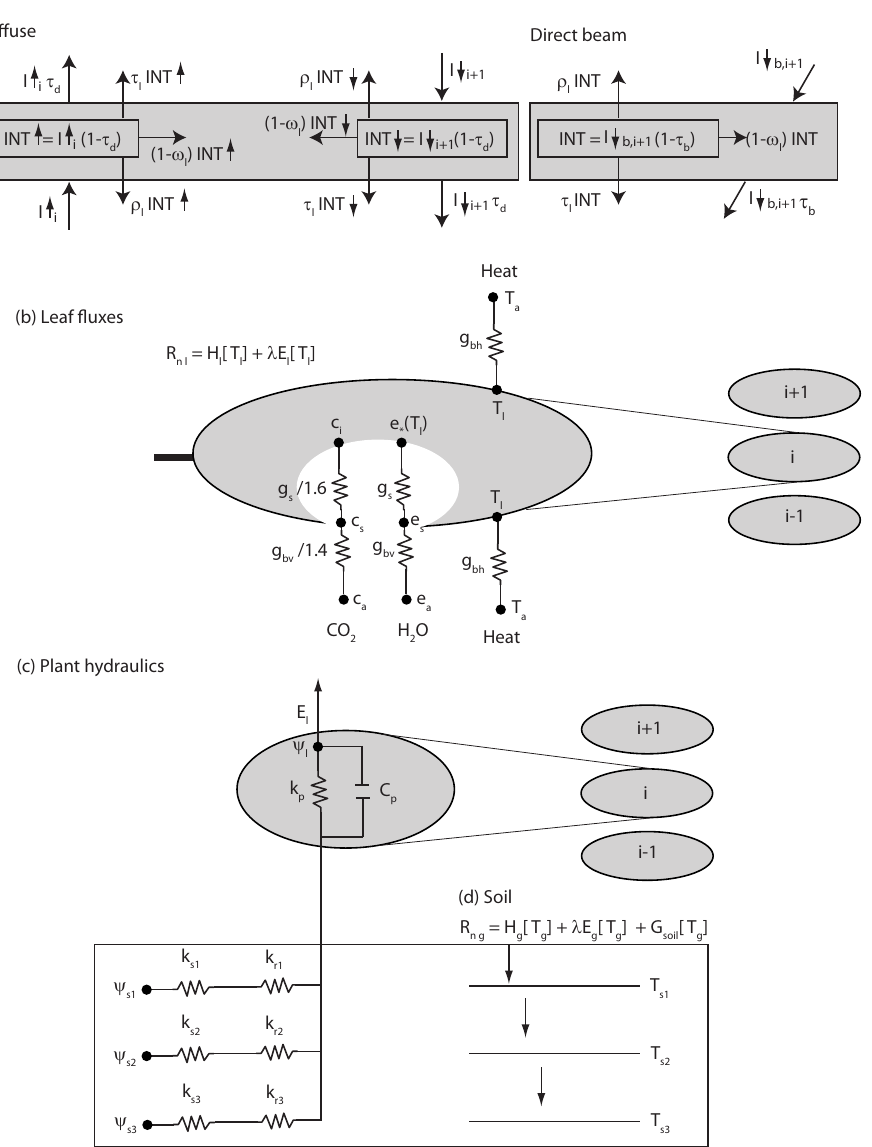
Figure 1. Overview of the main processes in the canopy model. The canopy is represented by n leaf layers with layer i + 1 above layer i . (a) Diffuse and direct solar radiation for layer i + 1. Diffuse radiation passes through the layer, proportional to τ d . The intercepted fraction (1 − τ d ) is scattered forward ( τ l ), scattered backward ( ρ l ), or absorbed (1 − ω l ; ω l = τ l + ρ l ). The intercepted direct beam (1 − τ b ) is similarly absorbed or scattered. Longwave radiation is similar to diffuse radiation, with ω l = 1 − ε l and the intercepted longwave radiation is reflected ( ρ l = ω l , τ l = 0). (b) Leaf sensible heat, transpiration, and CO 2 fluxes. Leaf temperature ( T l ) is the temperature that balances the energy budget. Sensible heat is exchanged from both sides of the leaf, proportional to the leaf boundary layer conductance ( g bh ) and the temperature gradient with air ( T l − T a ). Water vapor is lost from the stomatal cavity to air, proportional to the vapor pressure deficit ( e ∗ (T l ) − e a ) and stomatal ( g s ) and boundary layer ( g bv ) conductances in series. CO 2 similarly diffuses from the canopy air into the stomata, proportional to the gradient c a − c i . (c) Soil water uptake by a canopy layer. Each canopy layer has an aboveground plant stem conductance ( k p ) and a capacitance ( C p ). Multiple root layers occur in parallel with a conductance comprised of soil ( k s ) and root ( k r ) components in series. The soil conductance varies with soil water potential ( ψ s ). (d) Soil energy balance and heat flow. Sensible heat, latent heat, and soil heat fluxes depend on ground temperature ( T g ). The soil heat flux is transferred within the soil profile using a Crank–Nicolson formulation with soil heat flux as the upper boundary condition and soil heat capacity and thermal conductivity specified from soil texture, mineralogical properties, and soil water. Appendix A provides the full equation